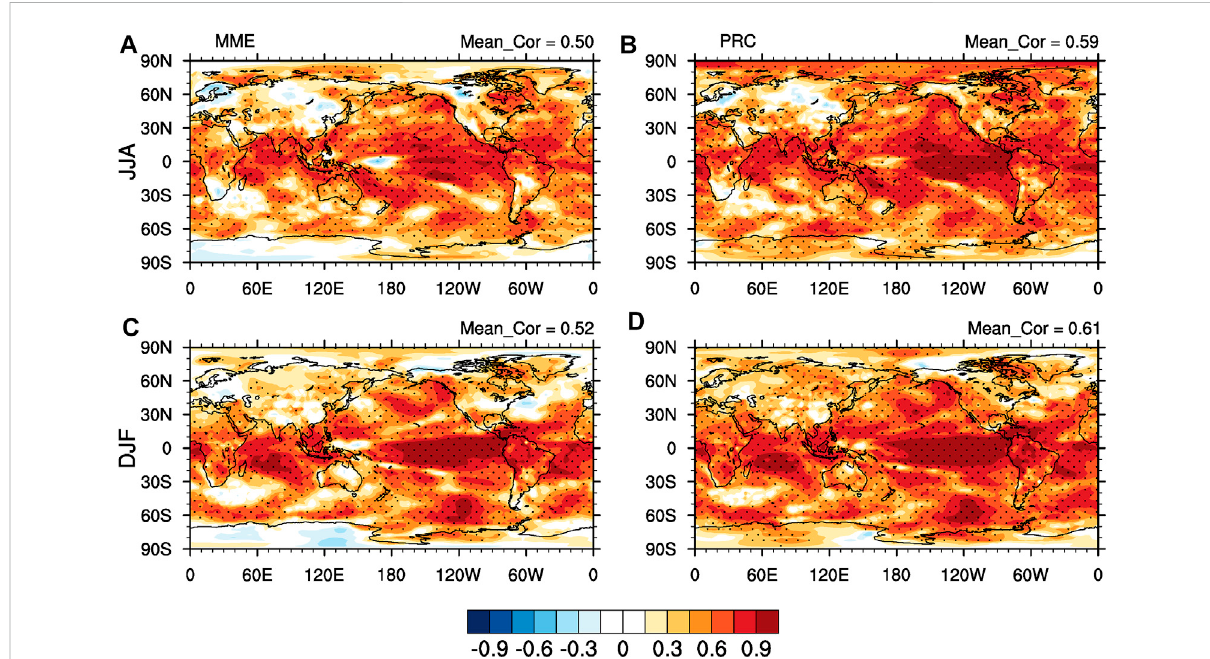
FIGURE 7 Spatial distributions of TCC for simple averaged multi-model ensemble (MME) (A,C) and the ensemble corrected with partial regression (PRC) (B,D) of temperature in JJA (upper panel) and DJF (below panel) season for the period 1982 – 2011. The global-averaged scores are also displayed in the upper right corner of the plot. The dotted areas indicate statistical signi fi cance at the 95% level using the Student ’ s t -test.